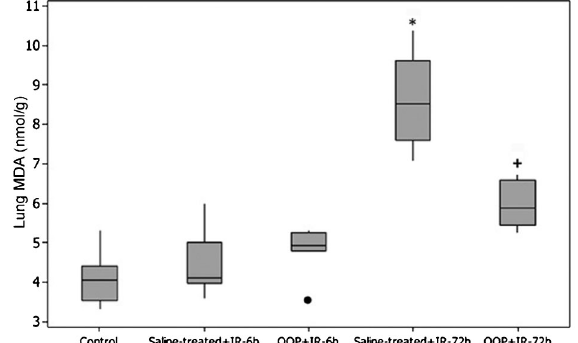
Figure 3. Malondialdehyde (MDA) levels in the lung tissues of control, saline-treated++ionizing radiation (IR), or ozone oxidative preconditioning (OOP)++IR groups decapitated at 6 or 72 h after irradiation. Each group consisted of 8 rats. Circle: outlier. *P=0.001 compared to control group; + P=0.001 compared to saline-treated group (Mann-Whitney